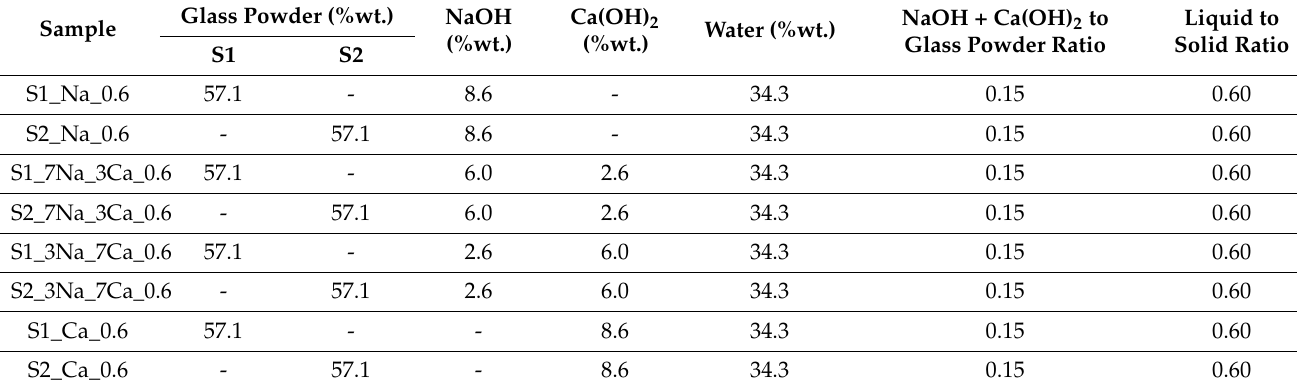
Table 1. Compositions of studied G-AAIP pastes.